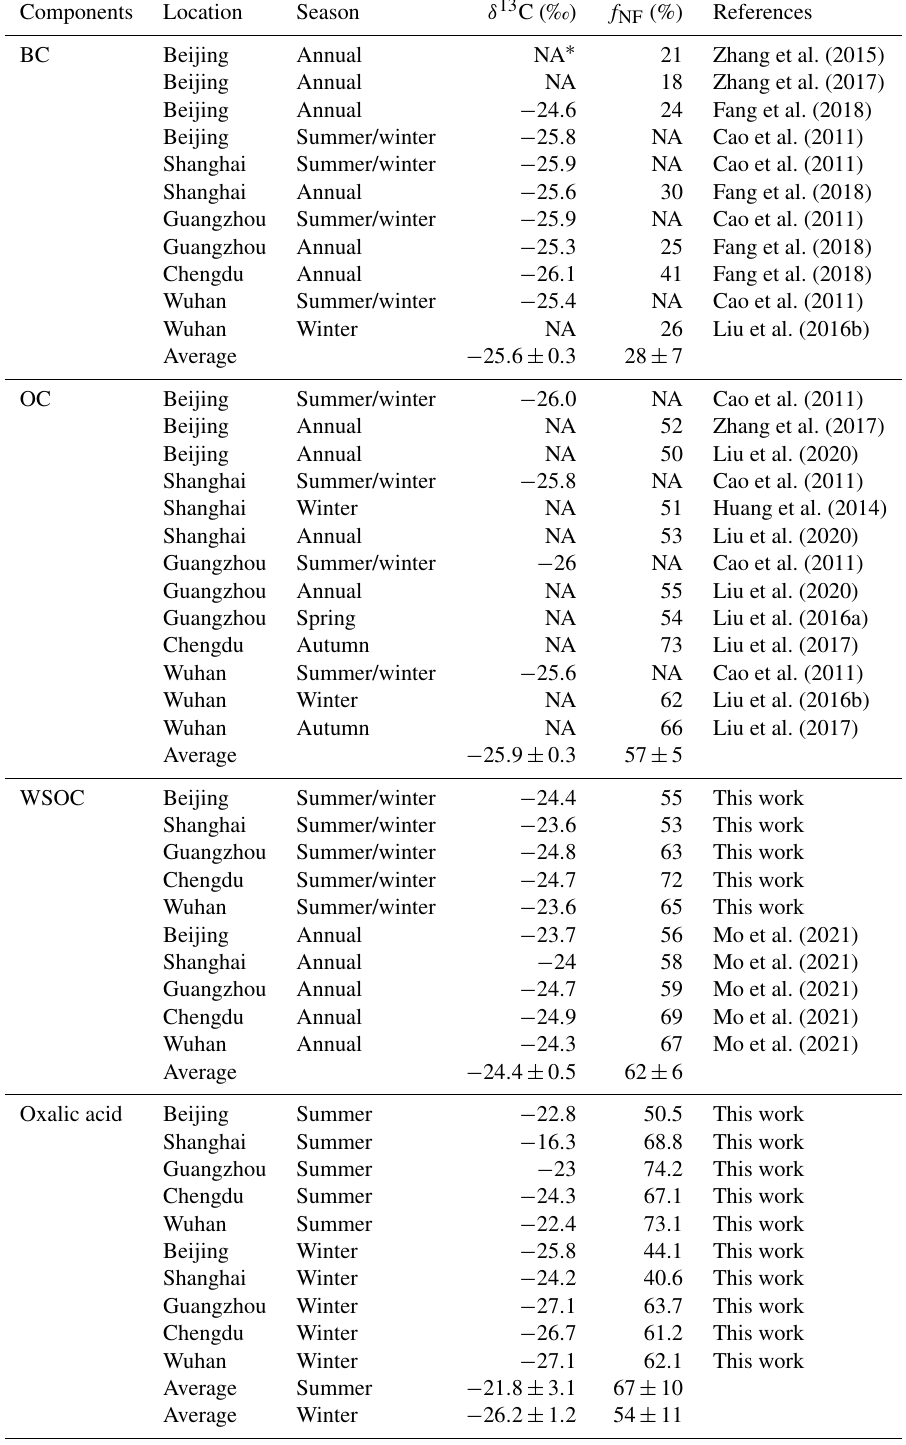
Table 1. Compilation of literature values of δ 13 C compositions and 14 C-based non-fossil source fraction ( f NF ) for black carbon (BC), organic carbon (OC), water-soluble organic carbon (WSOC), and oxalic acid in PM 2 . 5 samples collected from Beijing, Shanghai, Guangzhou, Chengdu, and